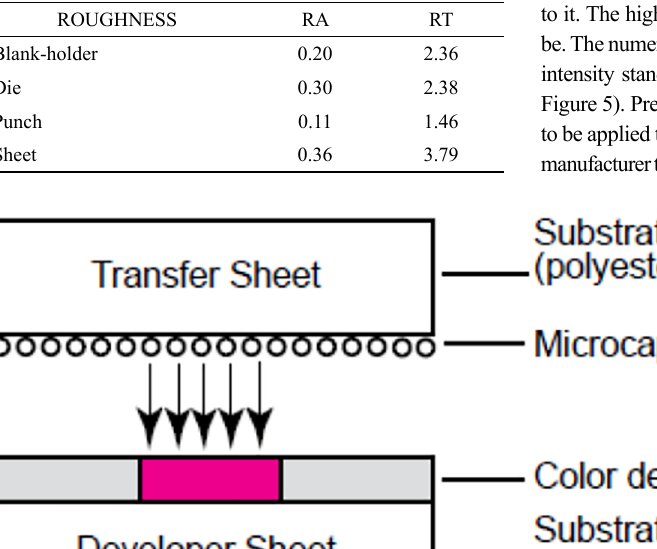
Table 2. Surface roughness parameters of tools and sheet material in µm.